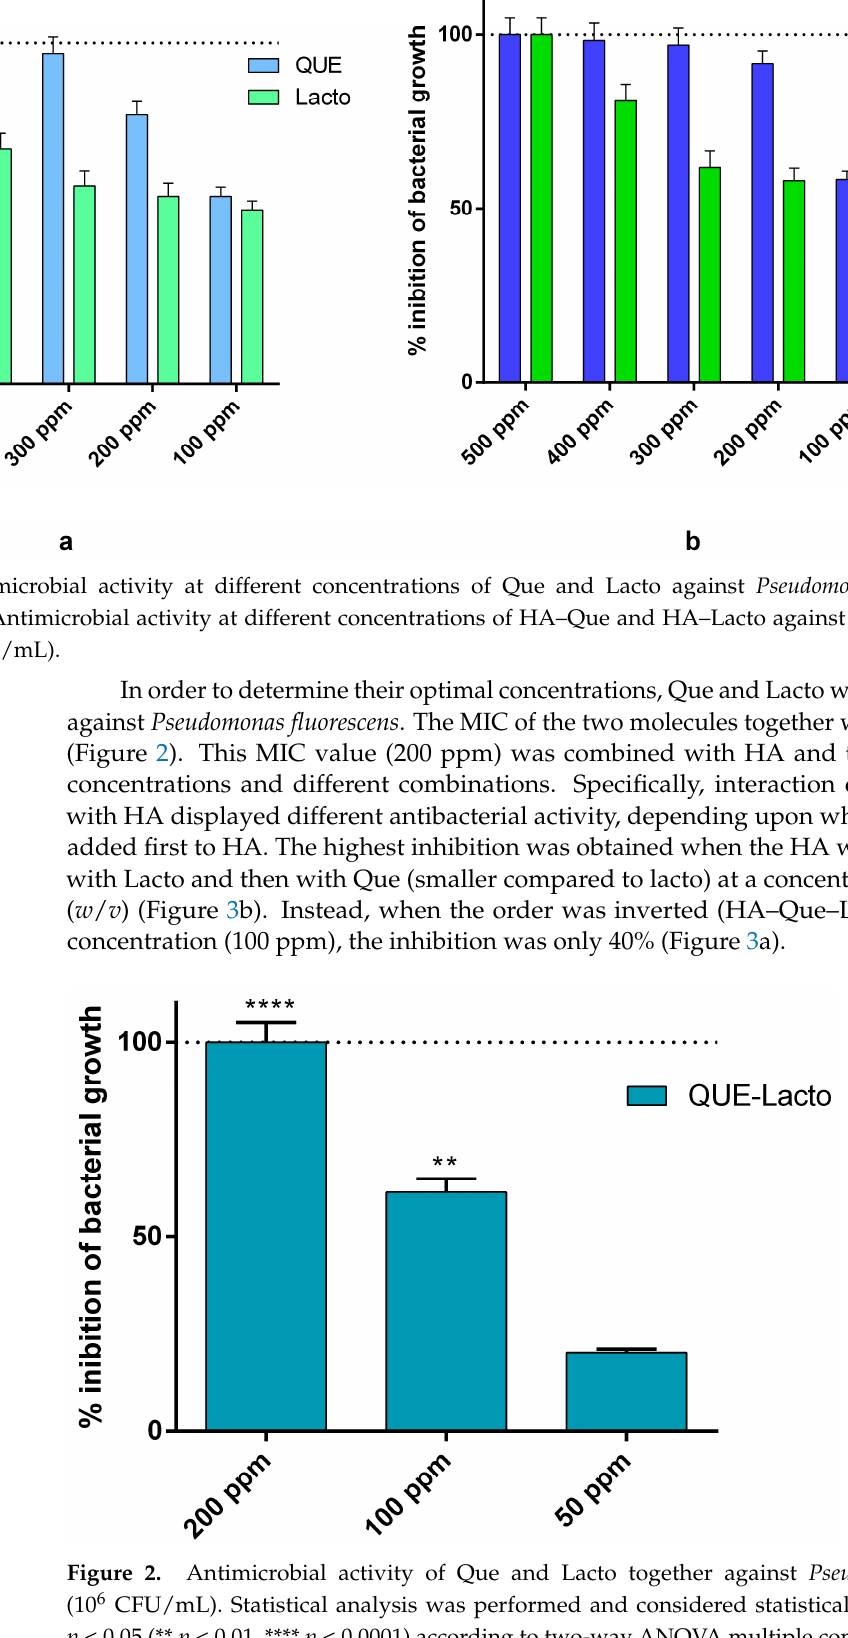
Figure 2. Antimicrobial activity of Que and Lacto together against Pseudomonas fluorescens (10 6 CFU/mL). Statistical analysis was performed and considered statistically significant when p < 0.05 (** p < 0.01, **** p < 0.0001) according to two-way ANOVA multiple comparisons.